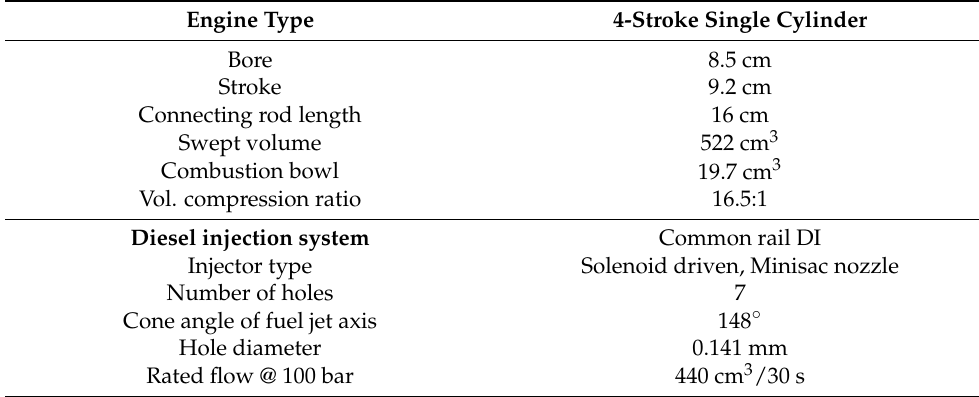
Table 7. Engine and injection systems